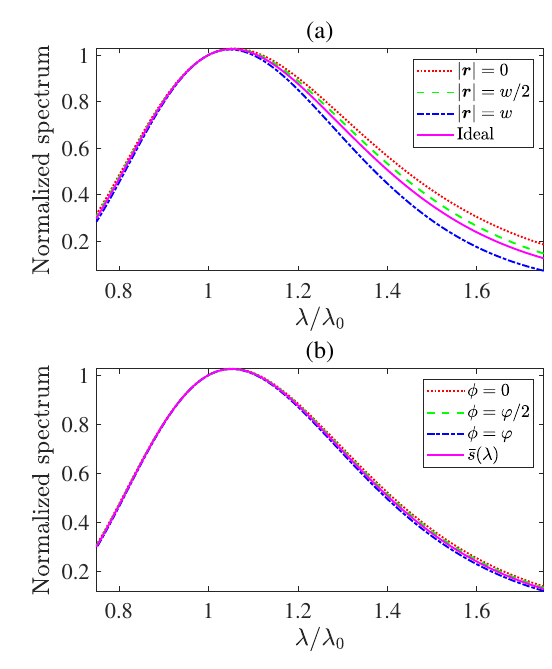
Figure 2. The magnifications for (a) cross-spectrally pure, and (b) spectrally invariant output fields. The solid lines show the ideal magnifications in Eqs. (1) and (2), together with the respec- tive approximations (dashed line) accomplished with the thin- element designs in Fig. 1. Adapted from [6].